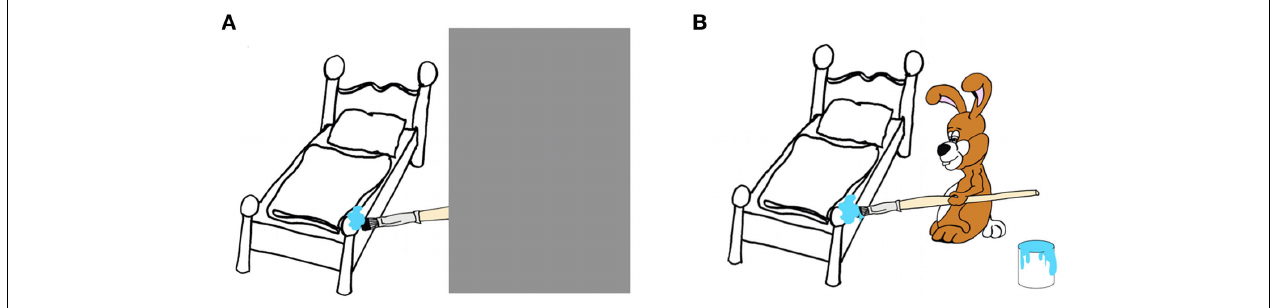
FIGURE 1 | Example trial of initial focus and final topic. (A) Experimenter: “Look! A bed (shown picture of a bed with blue paint on it). It looks like someone is painting the bed. Who is painting the bed?” (shape disappears to reveal a picture of a rabbit holding a brush next to a paint can) (B) . Participant: “The rabbit is painting a